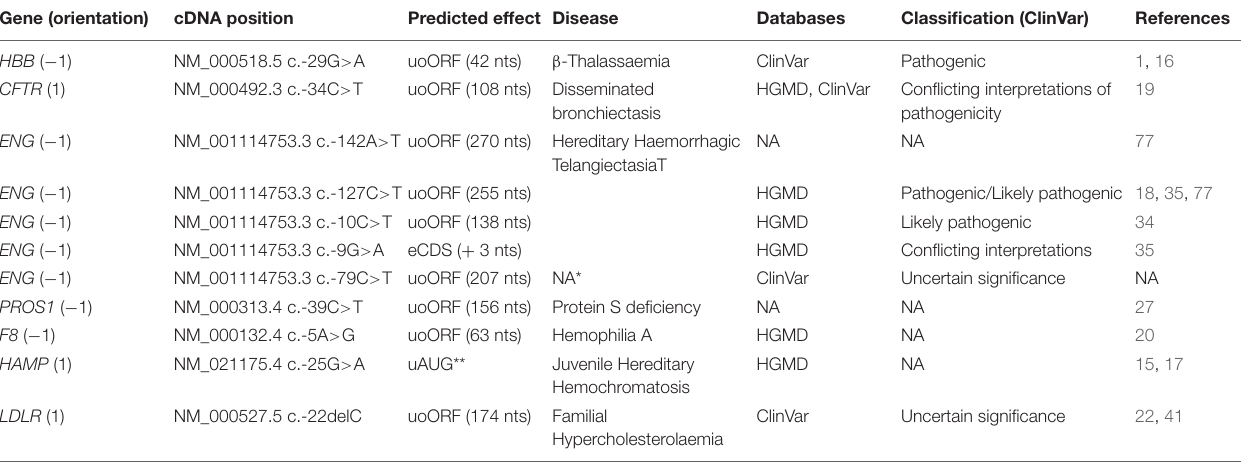
TABLE 1 | Rare upSNVs in CVD-related